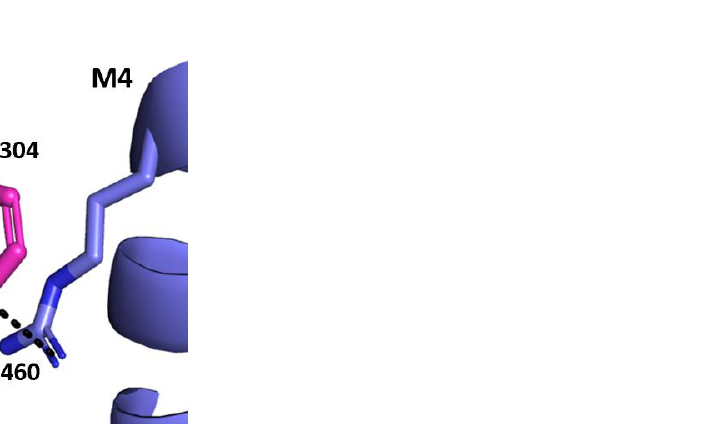
Figure 6. Potential W304-M4 interaction. The interface between the M1 helix (magenta) and the M4 helix (blue) showing the potential cation –π interaction between W304 and R460. Distances are in Å. * indicates a neighbouring subunit.